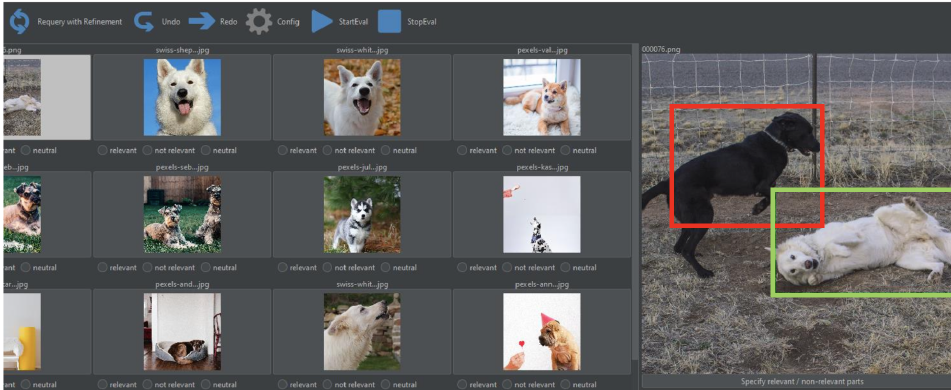
Figure 11. Snippet of the UI for query refinement and relevance